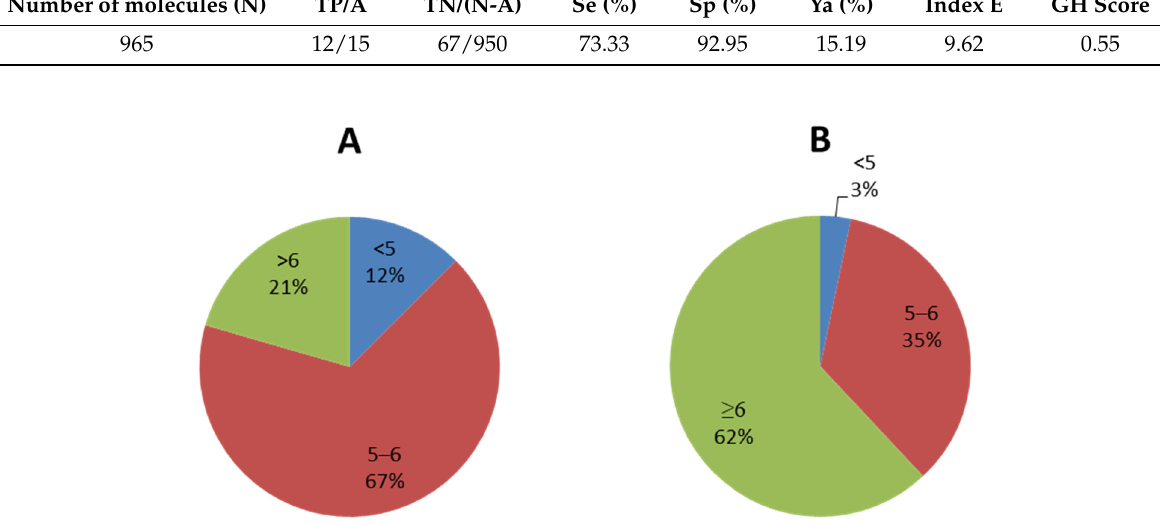
Figure 3. Binding sites determined by Site Finder Distribution of substances depended on biological activity in the satisfied ( B ) or unsatisfied pharmacophore model set ( A ).